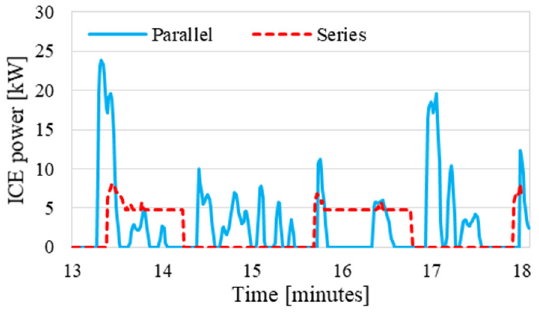
Figure 27. ICE power profile, comparison between parallel and series architectures (Urban).